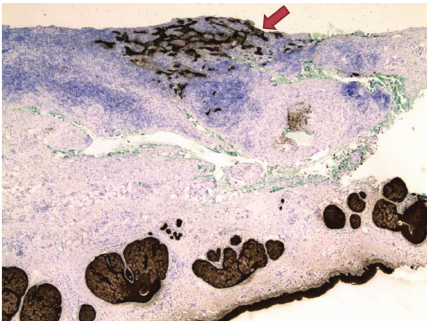
Figure 5: 20x magnification of tissue taken directly below the perforated cartilage (cartilage removed during immunostaining). Large pleomorphic cells staining positively for AE1/AE3 (arrow) are present in the posterior ear skin. The normal pilosebaceous units, eccrine ducts, and epidermis in the normal posterior ear skin serve as positive